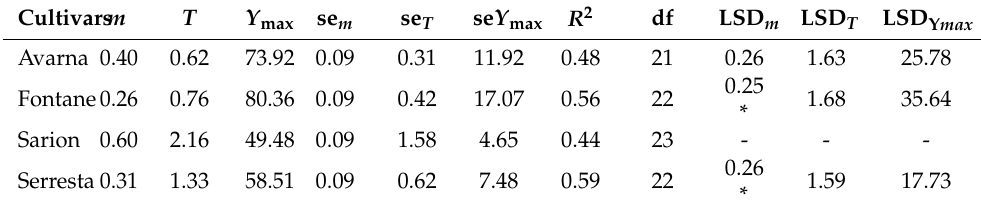
Figure 2. Relationship between P i, eggs (g dry soil) − 1 , and absolute fresh tuber yield in tons (ha) − 1 of four potato cultivars according to Equation (1). (( A ) Avarna; ( B ) Fontane; ( C ) Sarion; ( D ) Serresta). ( E ) Relative fresh tuber yield of all the cultivars combined. Table 2. The output parameter values (Equation (1)) of four potato cultivars: Avarna, Fontane, Sarion, and Seresta, where m = relative minimum yield; T = tolerance limit in eggs (g dry soil) − 1 ; Y max = maximum yield in tons per ha at P i = 0 eggs (g dry soil) − 1 ; se m = standard error of relative minimum yield; se T = standard error of tolerance limit; se Y max = standard error of maximum yield; R 2 = coefficient of determination; df = degrees of freedom. * Significantly different parameter values compared to cv. Sarion at 5% level of significance. LSD = least significant difference.